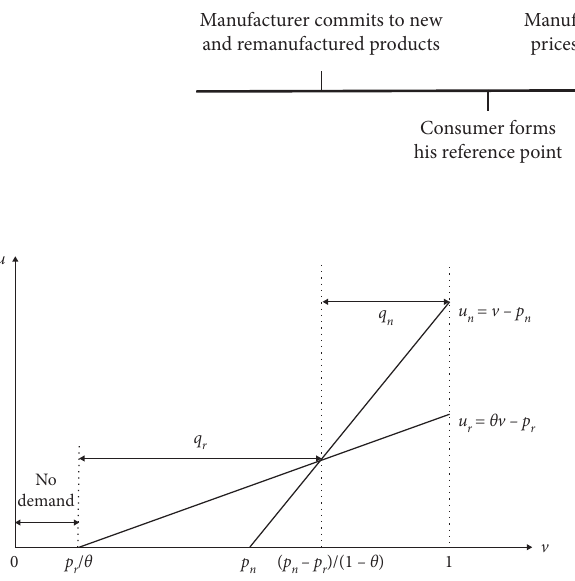
Figure 2: The loss-neutral consumer